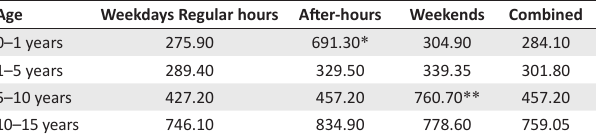
TABLE 4: 75th percentile of Dose Length Product (mGy * cm) data distribution, categorised for time and age for computed tomography brain examinations at Charlotte Maxeke Johannesburg Academic Hospital ( n = 515).